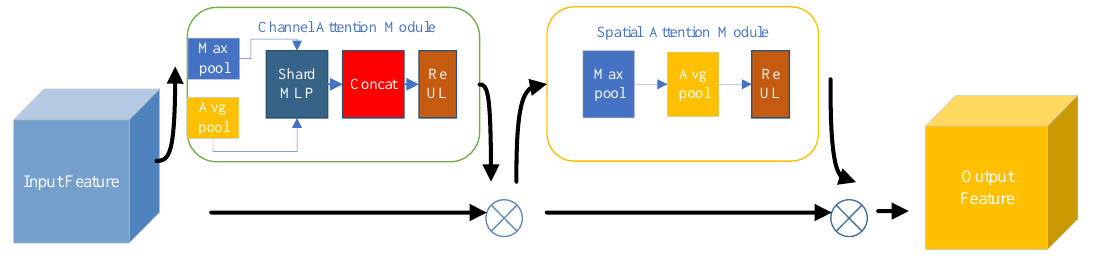
Figure 6. CBAM structure